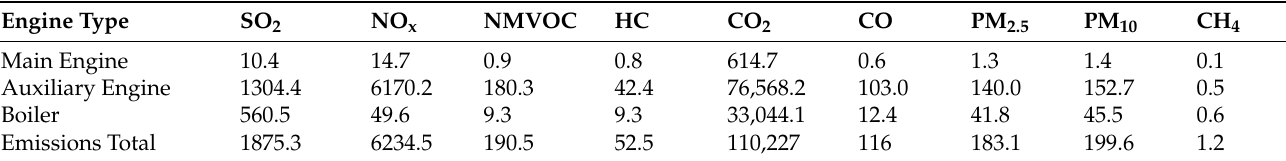
Table 3. Ship emissions of different engine category